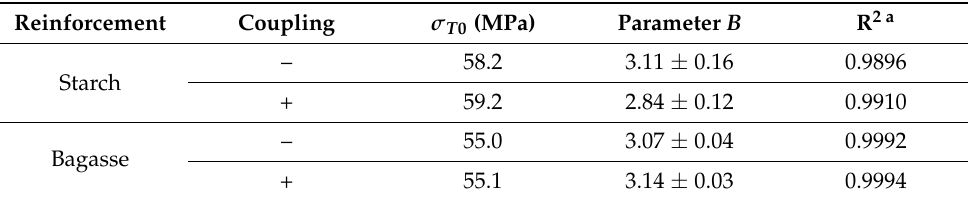
Equations (1) and